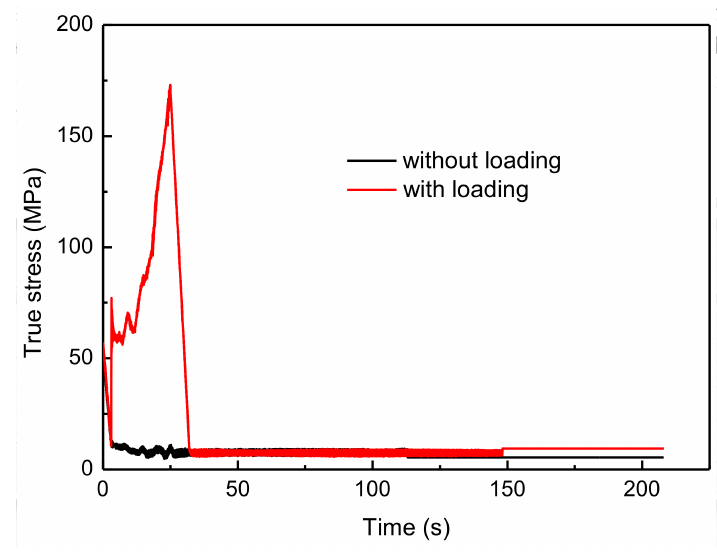
Figure 4. The stress state of the welding thermal simulation specimens.